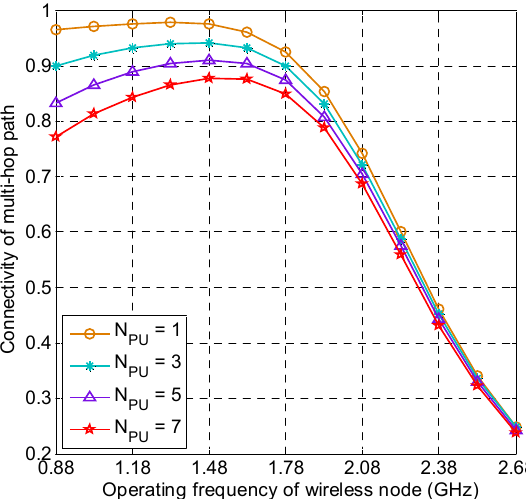
Figure 9 . The connectivity of multi-hop path in CRAHNs with different number of PUs; network size = 2000 m × 2000 m, number of SUs = 100, average = 0.1, one frequency layer with active rate of PU l PU operating frequency = 0.88 GHz ~ 2.68